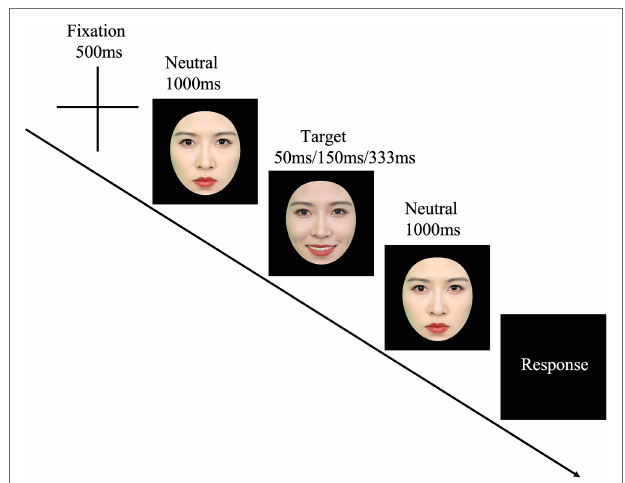
FIGURE 1 | The JACBART paradigm. Note that we use the facial images of the second author for